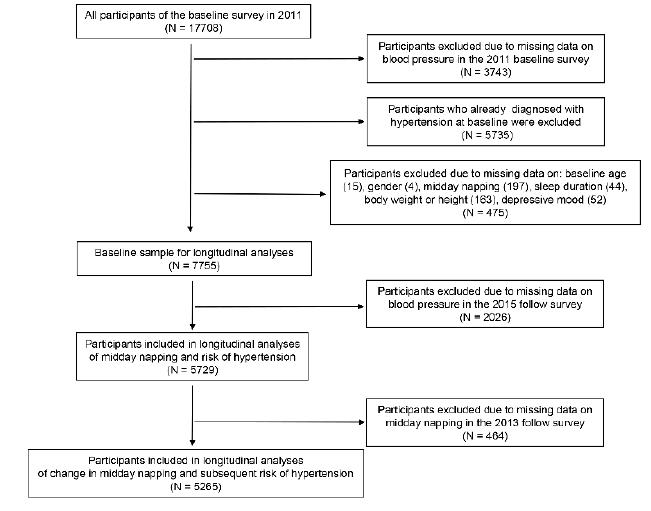
Figure 1. Flow chart of participants.